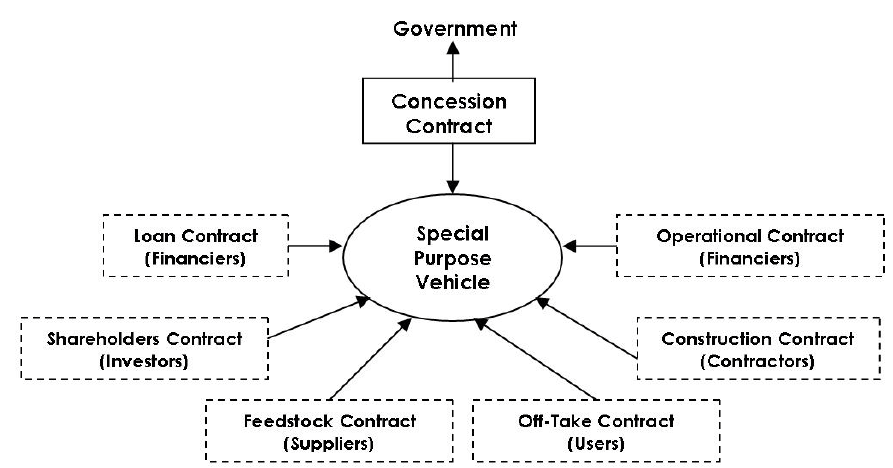
Figure 1. "Primary and Secondary Contracts in